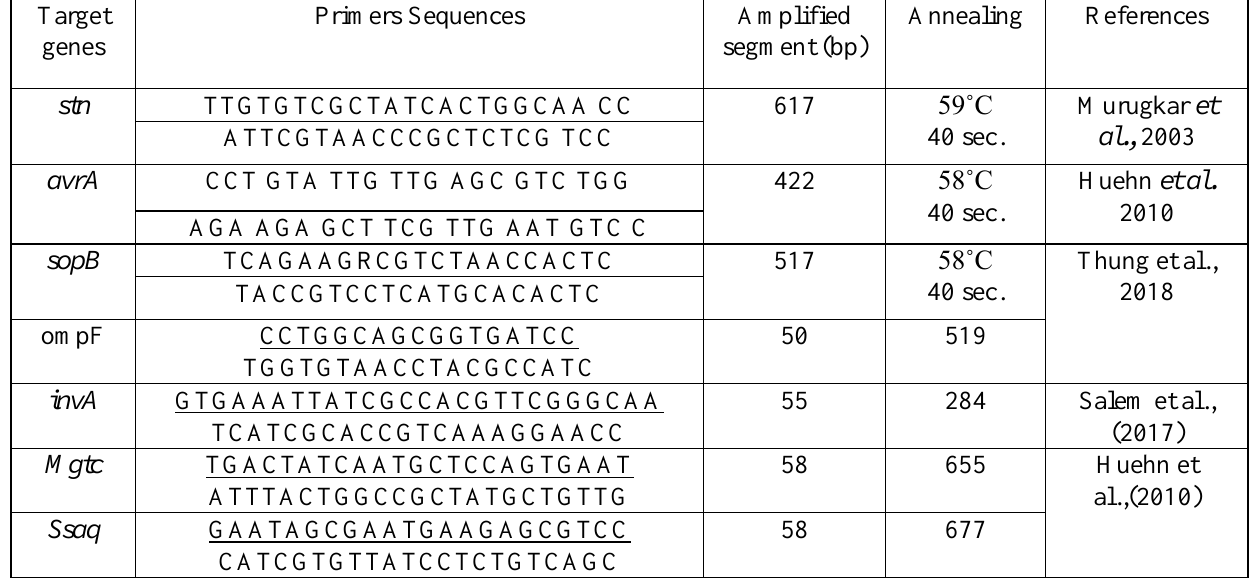
Table 1: Primers sequences, target genes, amplicons sizes, and cycling conditions: